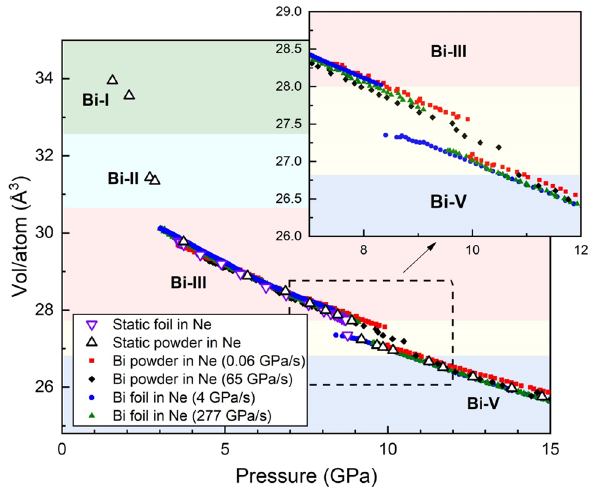
Figure 3. Volume/atom as a function of pressure for selected dDAC compression ramps on Bi samples loaded with Ne. Data from fast and slow dDAC compressions of both Bi foil and powder samples are compared with the results from static compression experiments on Bi powder and foil samples loaded in Ne from Fig. 1. The inset shows an enlargement of the ramp data in the vicinity of the Bi-III/Bi-V transition to highlight the different transition pressures. The pressure was estimated from the Au pressure standard as described in the text.